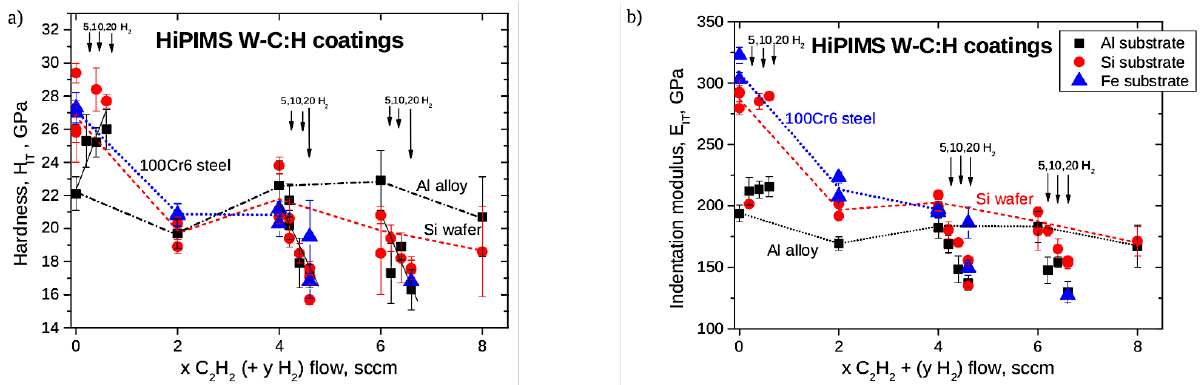
Figure 2. The comparison of the hardness, H coatings deposited at different acetylene (and hydrogen) additions on three types of substrates. The data-points corresponding to 5, 10 and 20 sccm H better